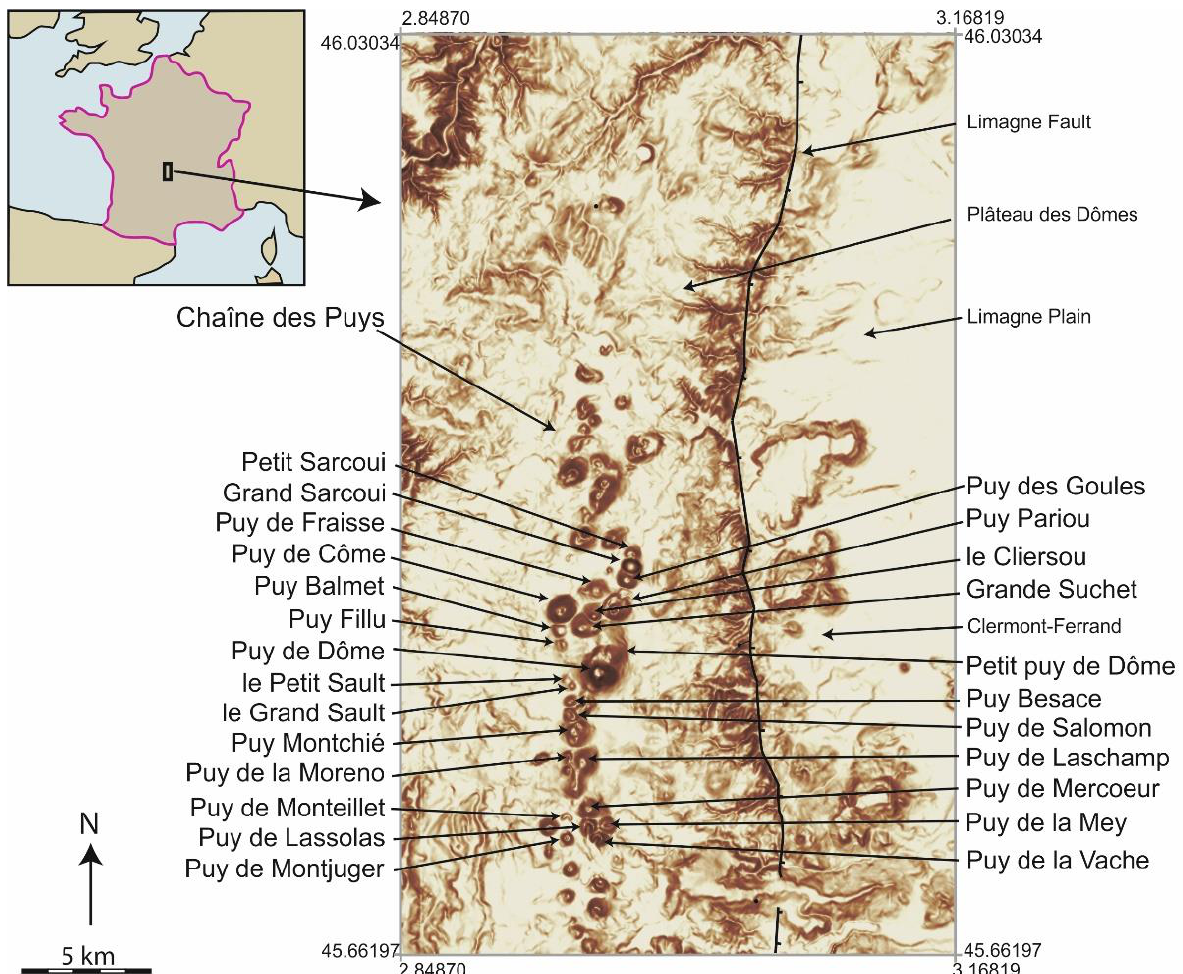
Figure 2. Slope map of the Chaîne des Puys volcanic field and its surrounding (regional 10 m CRAIG DTM, modified from [30]) for identification of the cones (see the IDs in Table 1).